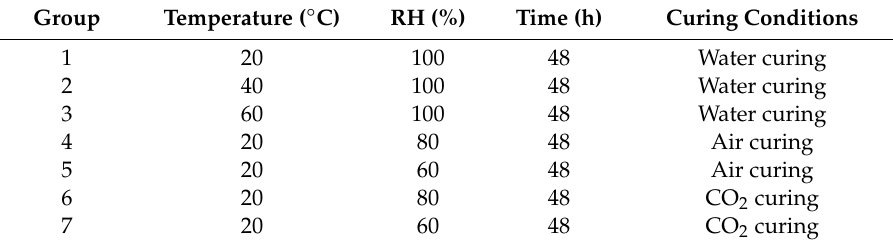
Table 7. The early age-curing